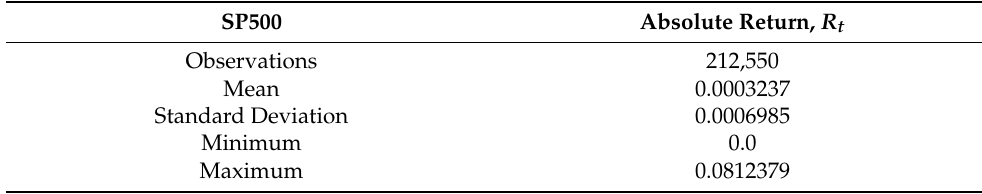
Table 1. S&P 500 Index Return Descriptive Statistics.